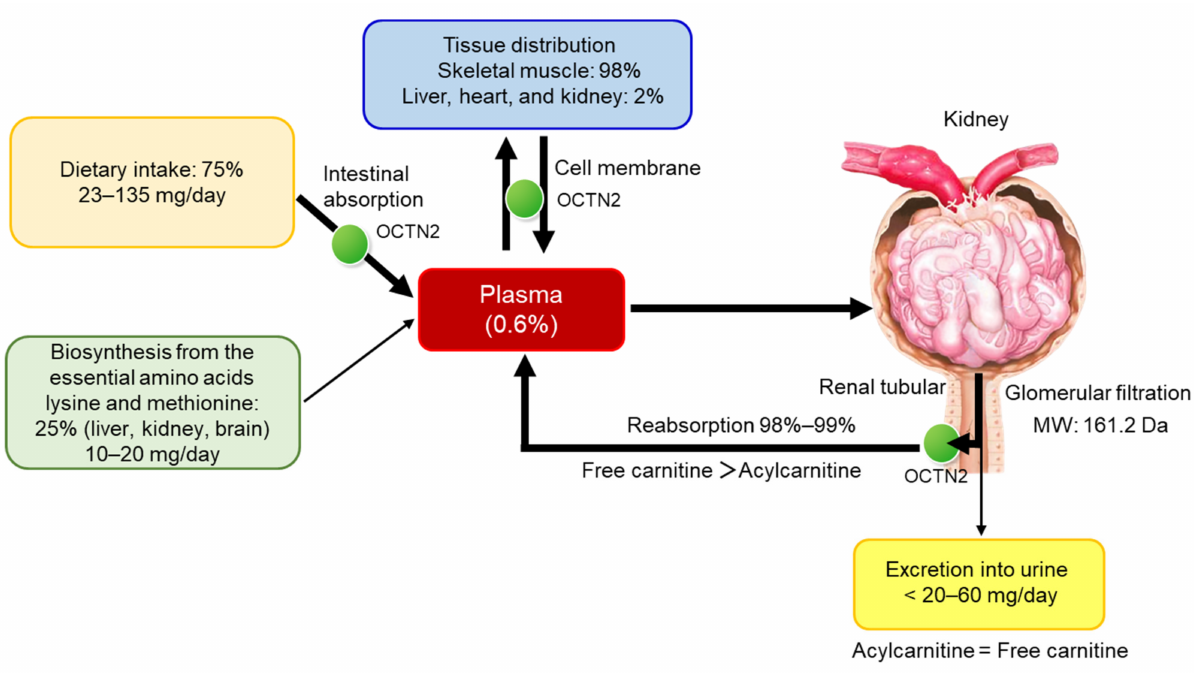
Figure 2. Carnitine homeostasis. MW, molecular weight; OCTN2, organic cation/carnitine transporter